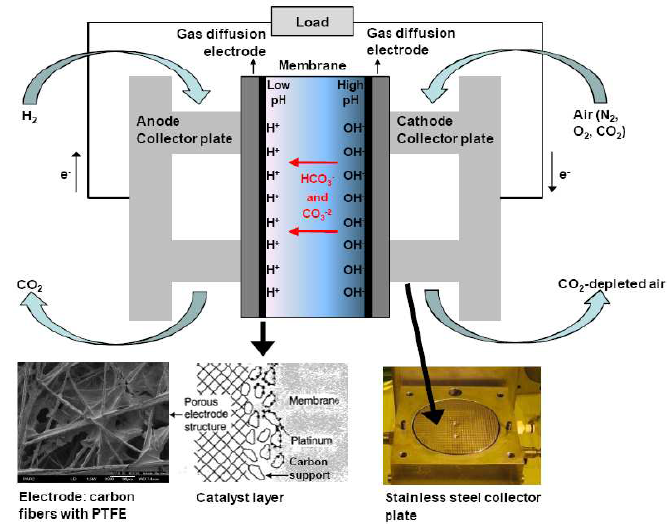
Figure 8. Fuel cell concentrator scheme. Reproduced under the techconnect license [23].